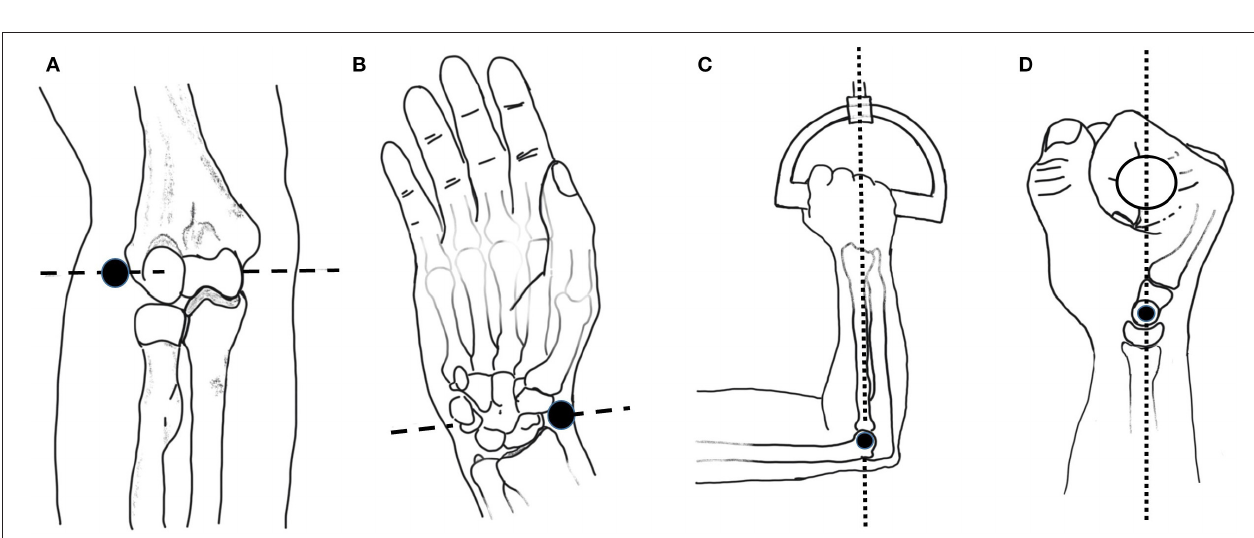
FIGURE 2 | Anatomical landmarks and rotation axes: (A) Elbow axis (dashed line) and radiale landmark (black dot); (B) Wrist flexion/extension axis (dashed line) and stylion landmark (black dot); (C) Upper arm at horizontal with elbow at 90 degrees and handle rotation axis (dotted line) passing through the 4 th metacarpophalangeal joint; (D) Grip alignment between wrist flexion-extension axis (black dot) and handle rotation axis (dotted line). Images adapted from Neumann